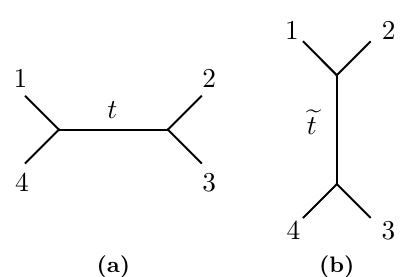
Figure 13. Two four-point tree graphs which are dual to each other (in the sense of dual-resonance models).